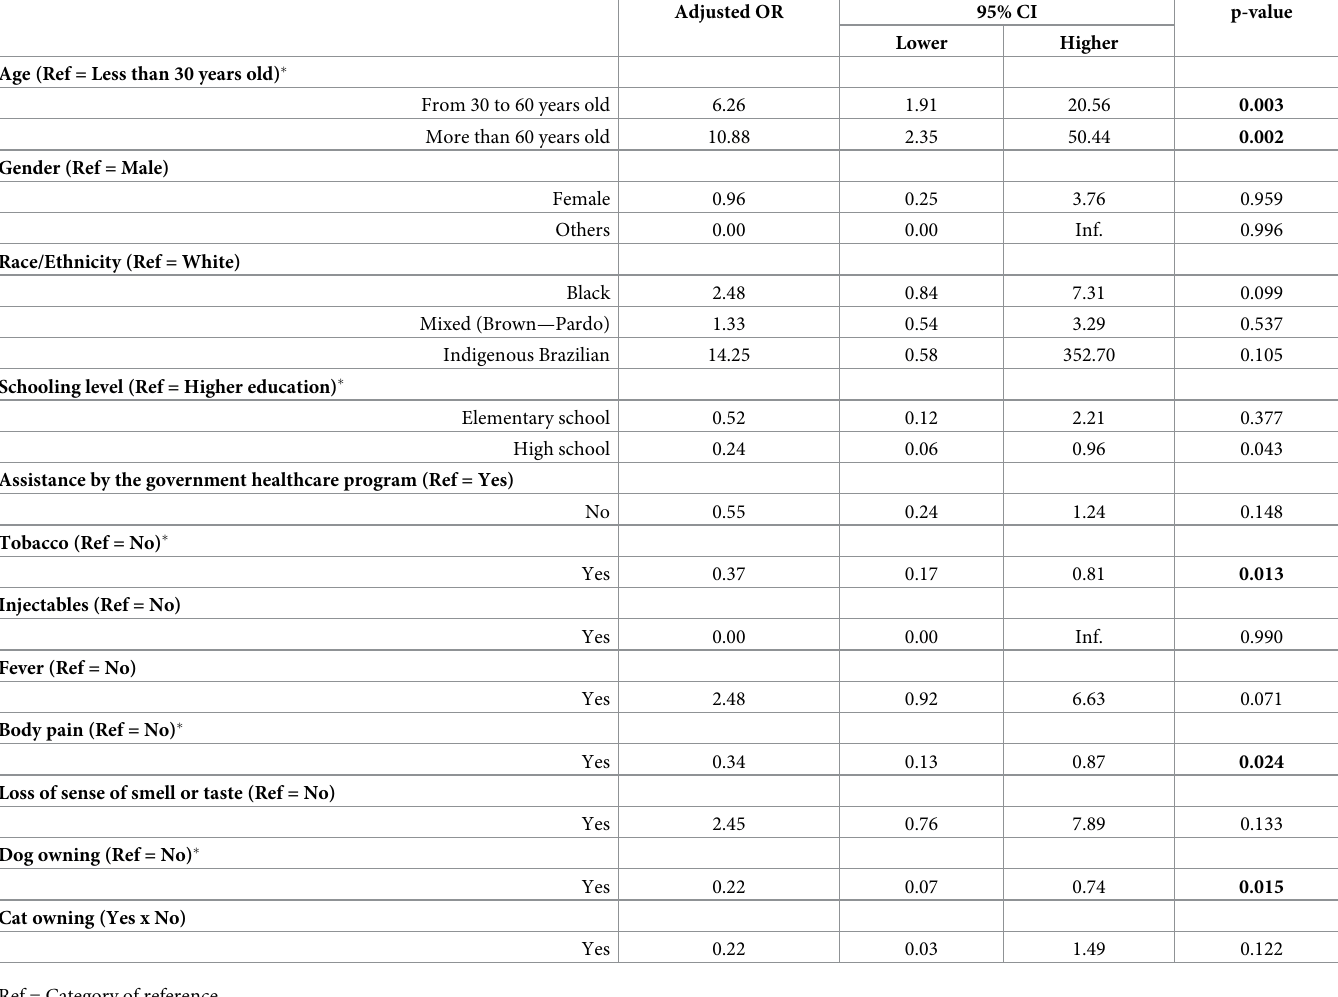
Table 3. Final logistic model for analyzing risk factors associated with seropositivity of anti-SARS-CoV-2 IgG in 203 persons experiencing homelessness of S ã o Paulo,